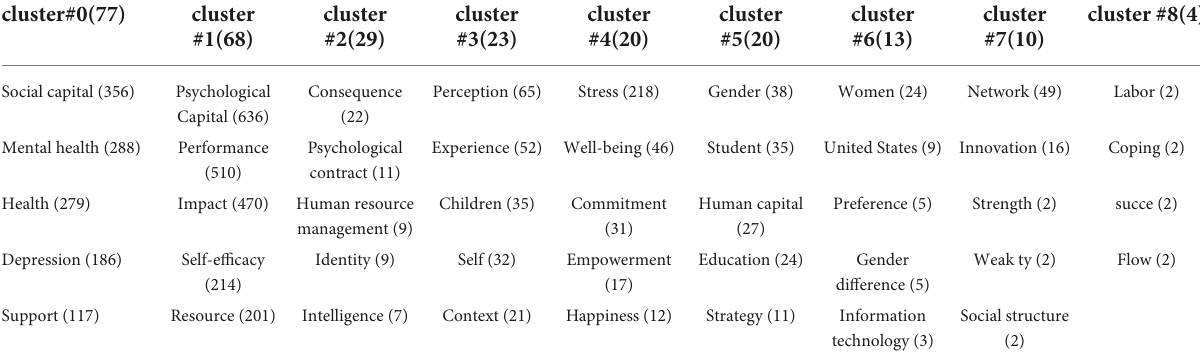
TABLE 7 Co-occurrence of keywords in